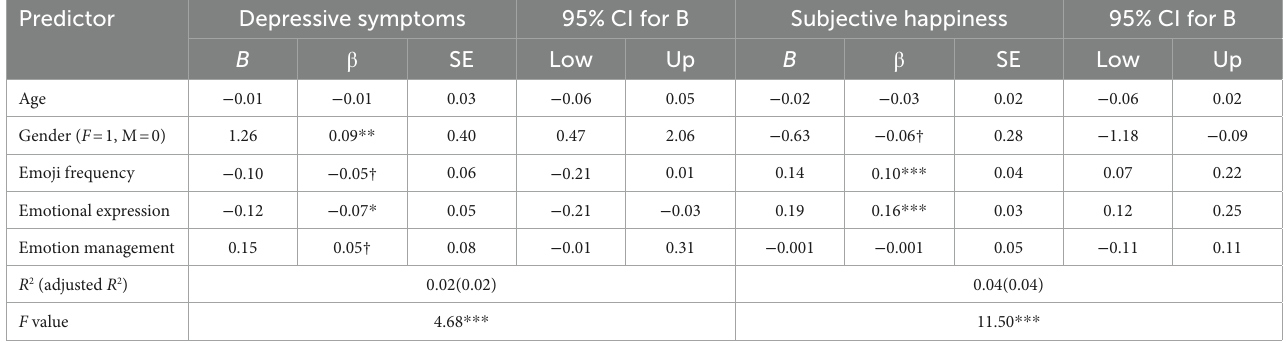
TABLE 7 Regression analyses for mental health.